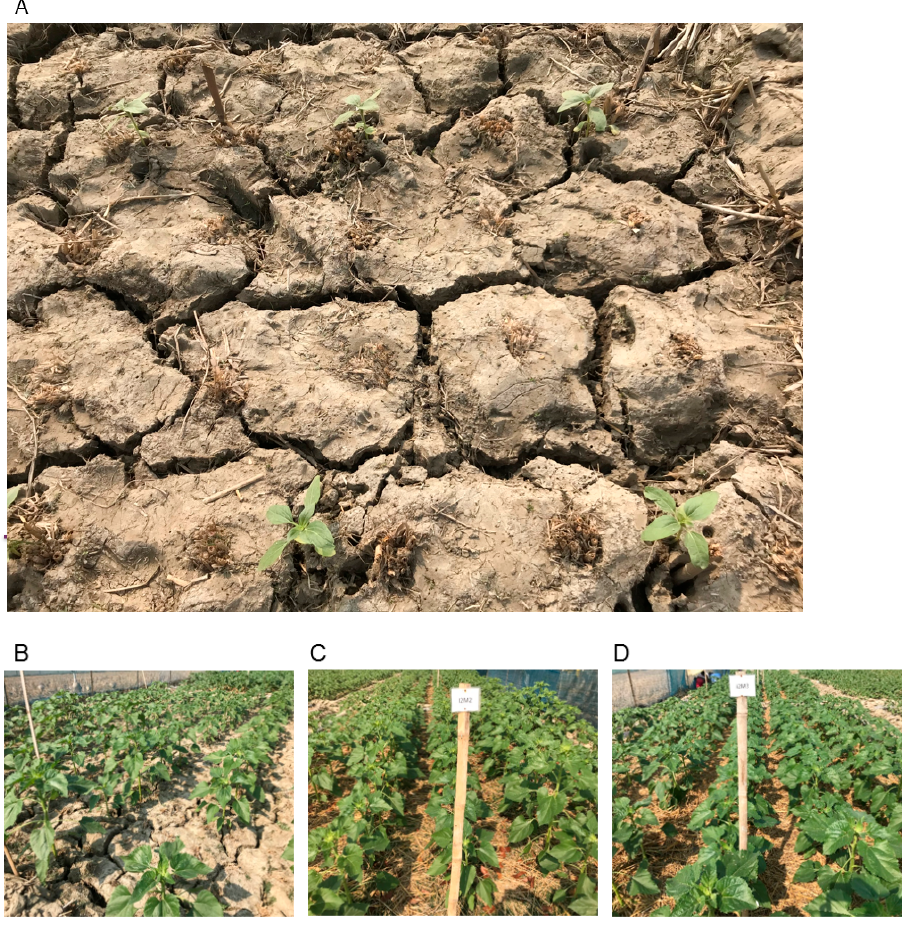
Figure 2. Pictorial view of cracked soil during sunflower growth ( A ) and the effects of mulch treatments on sunflower growth: ( B ) no-mulch, ( C ) mulch at 5 t ha − 1 , and ( D ) mulch at 10 t ha − 1 .